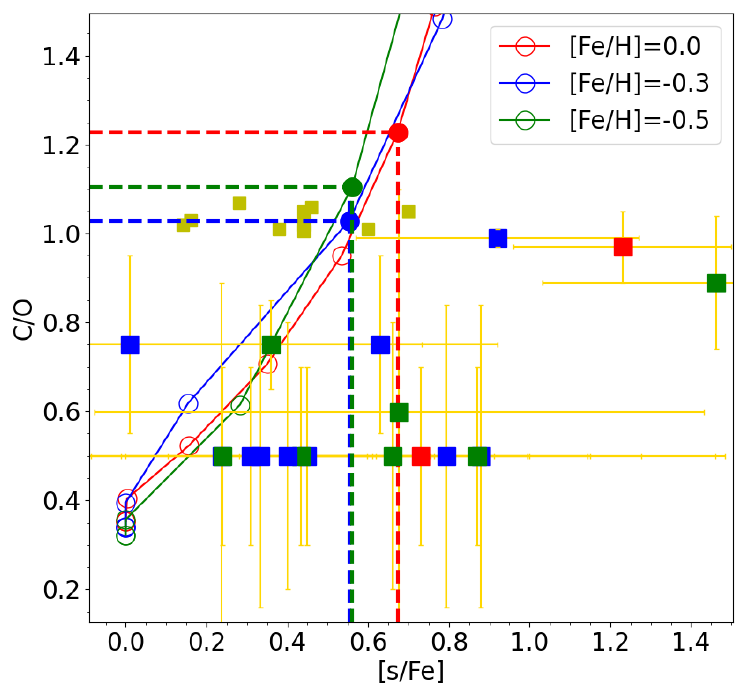
Figure 2. C/O ratio as a function of [s/Fe] for intrinsic (i.e., Tc-rich) S-type stars and carbon stars. Red, blue and green squares identify intrinsic S stars in the metallicity bins [0.0; − 0.2], [ − 0.2; − 0.4] and < − 0.4. Tc-rich carbon stars from [90] are represented with small light green squares, clustering in the range C/O ∼ 1–1.1. Predictions for a 2 M (cid:12) STAREVOL model [21,22] at metallicities [Fe/H] = 0.0 (red), − 0.3 (blue) and − 0.5 (green) are overplotted. The empty circles along the tracks indicate the successive third dredge-up events along the TPAGB, while the three filled circles mark, for each considered metallicity, the third dredge-up events allowing to reach C/O > 1. According to models, no S-type star should be located at [s/Fe] larger than the ones indicated by the three blue, red and green filled circles (and corresponding vertical dashed lines). Figure adapted from